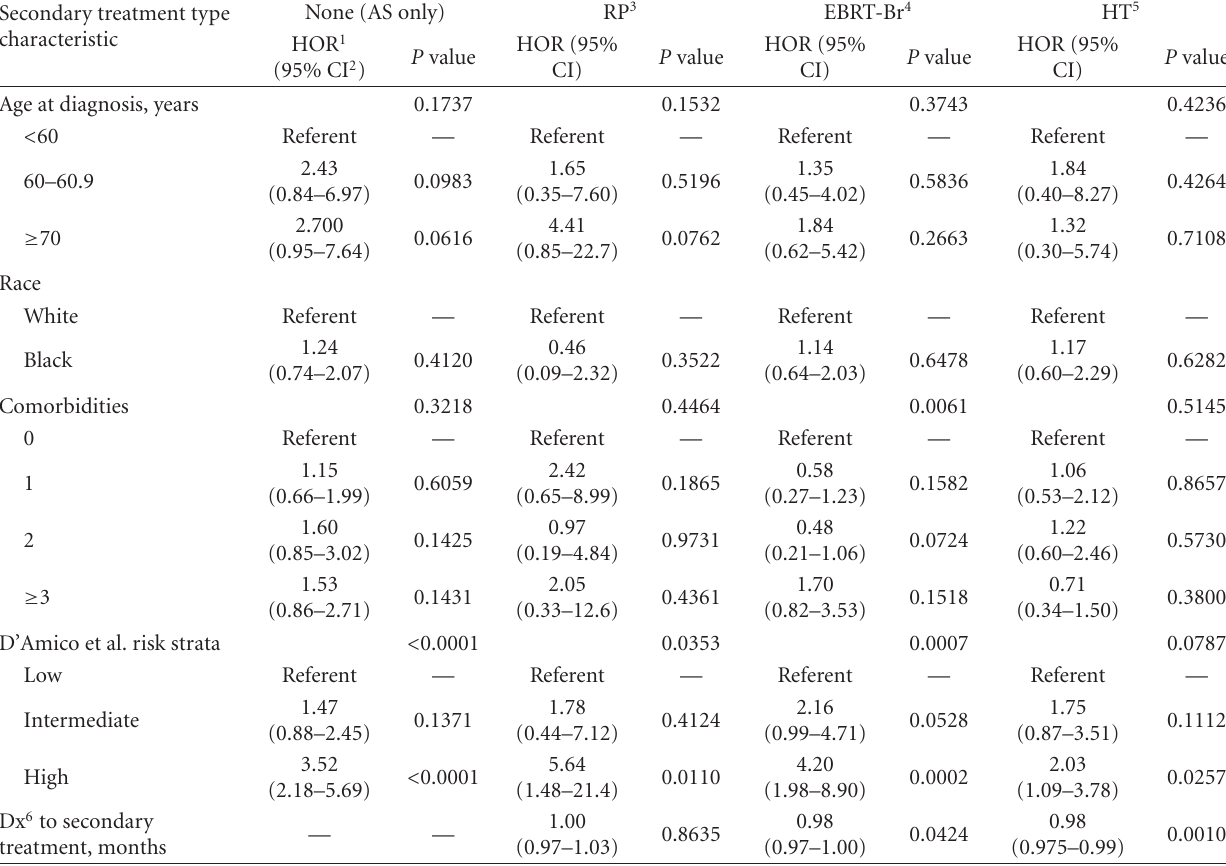
Table 4: Multivariable Cox proportional hazards model predicting overall survival in a cohort of subjects with prostate cancer (CaP) followed on active surveillance (AS) for primary treatment, stratified by secondary treatment